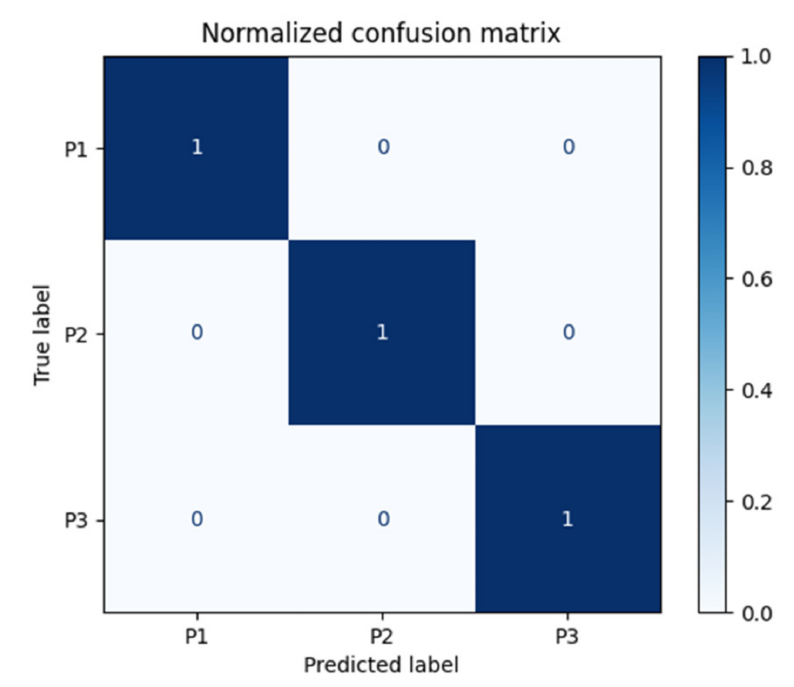
Figure 9. Normalized confusion matrix for KNN.